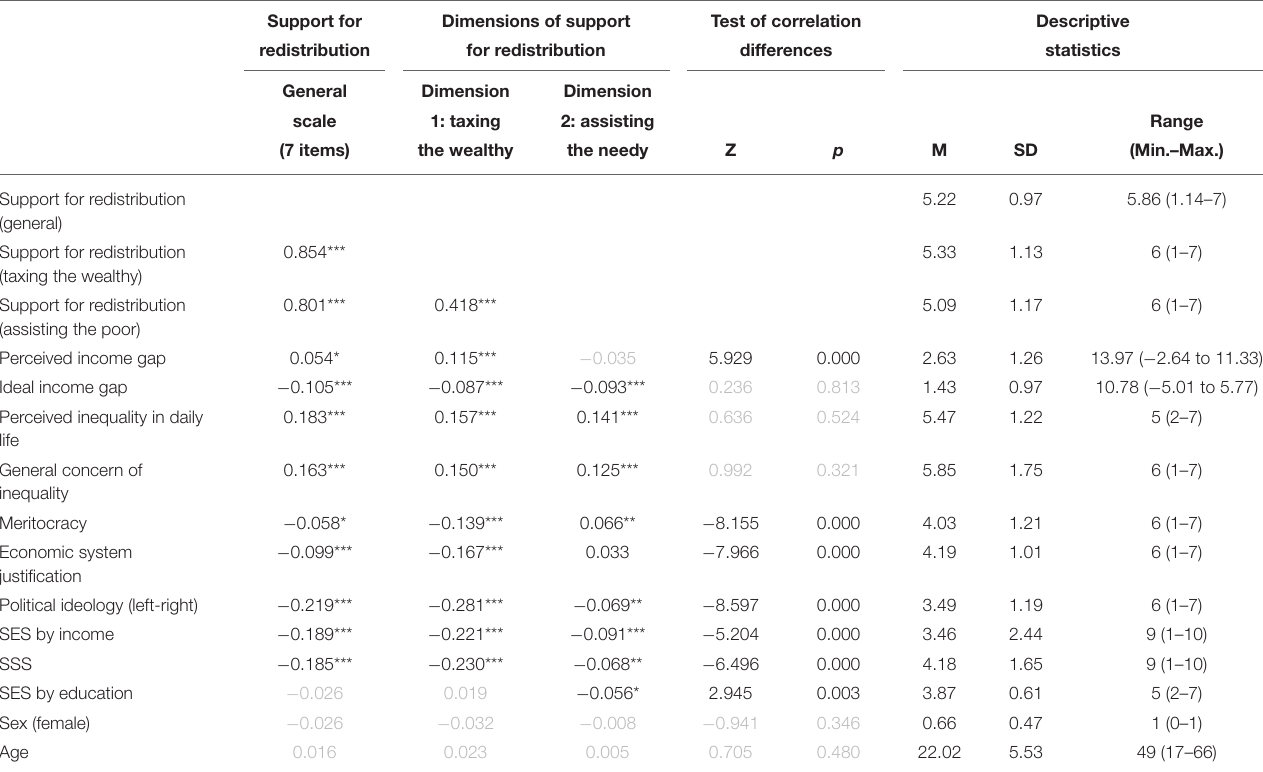
TABLE 2 | Zero-order correlations between support for redistribution and other variables included in Study 2, comparison of the correlation differences between dimension of redistribution, and descriptive statistics. Support for Dimensions of support Test of correlation